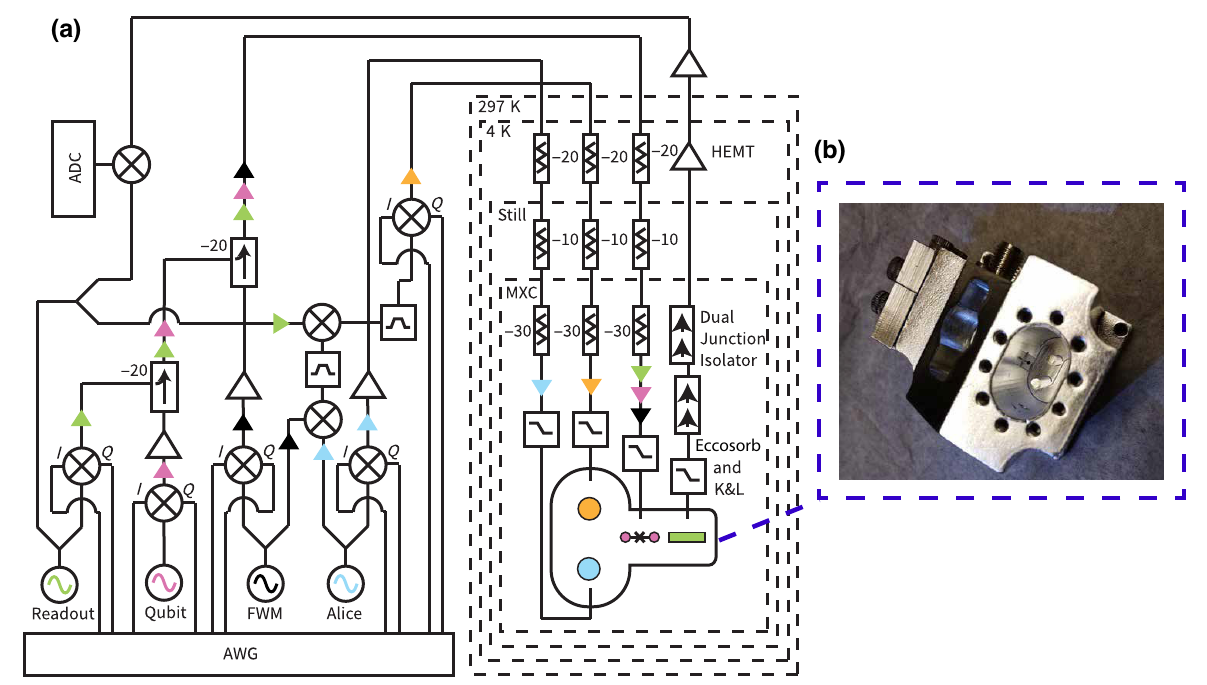
FIG. 7. (a) The refrigerator and measurement wiring diagram. We have four signal generators which, with eight AWG channels, make input signals for all the modes and FWM tone. The measurement setup shows that the drive signal for cavity b is generated by mixing the signals from cavity a , the reservoir, and the FWM generators with three-port mixers and using the correct sideband filters. (b) The high-purity aluminum cavity used in the experiment. The posts that give the storage-cavity modes are seen inside the aluminum body, with the sapphire chip entering the cavity from a side tunnel. The chip is held by an aluminum clamp and the transmon-qubit antenna is at equal distance from both of the posts. The cavity is mounted on a bracket that is placed inside a high-permeability magnetic shield thermalized to the mixing